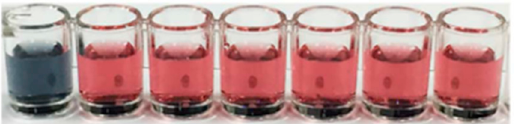
Figure 17. Selectivity of aptamer-modified gold nanoparticles for streptomycin. From left to right: streptomycin, amoxicillin, tetracycline, oxytetracycline, carbamazepine, diclofenac and penicillin added to aptamer-modified gold nanoparticles, ABTS and H 2 O 2 . (Reprinted with permission from [164] . Copyright © The Authors. Distributed under a Creative Commons (CC BY-NC) license).